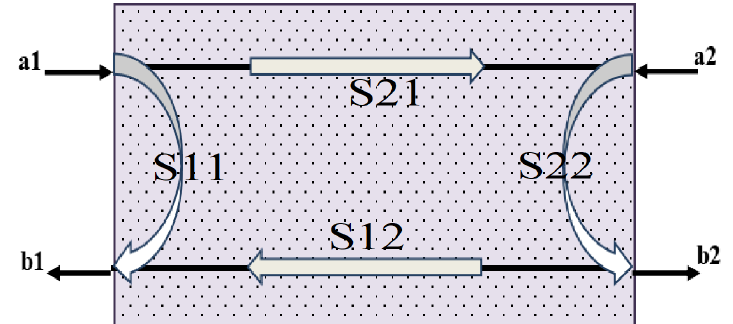
Figure 9. Proposed EMI shielding mechanism.